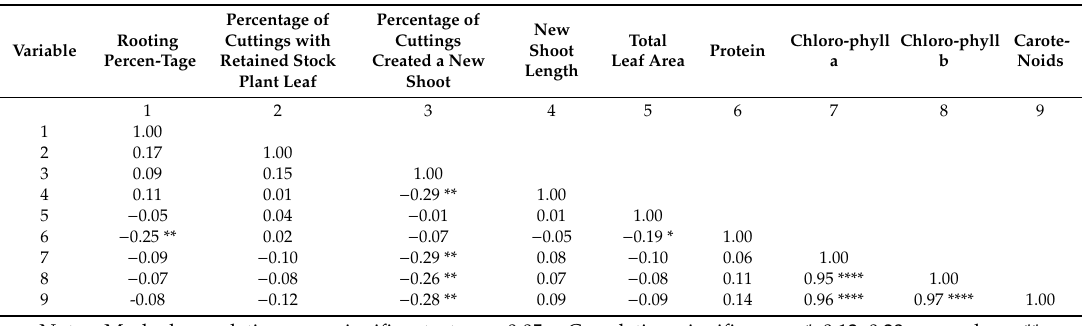
Table 4. Correlations matrices between rooting percentage and growth parameters, pigments, and soluble proteins content for cutting derived from shoots with flower buds closed in Rosa ‘Maiden’s